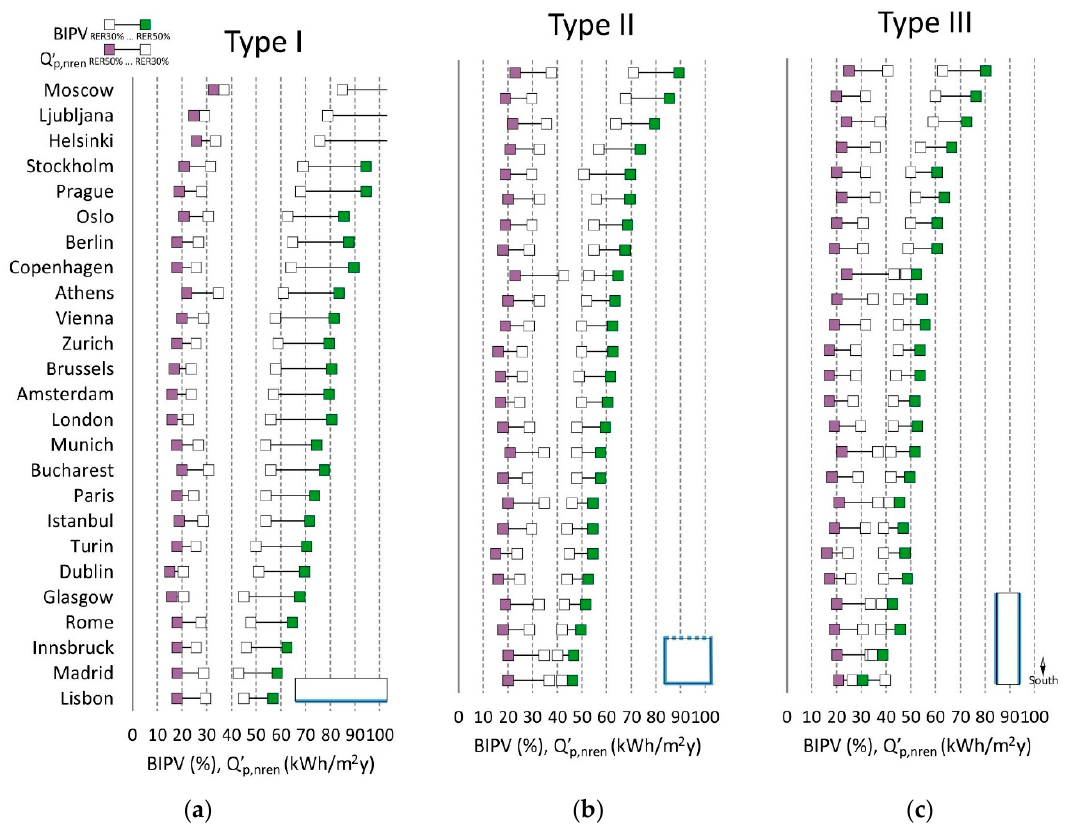
Figure 10. Yearly specific non-renewable primary energy needed for the operation of reference buildings